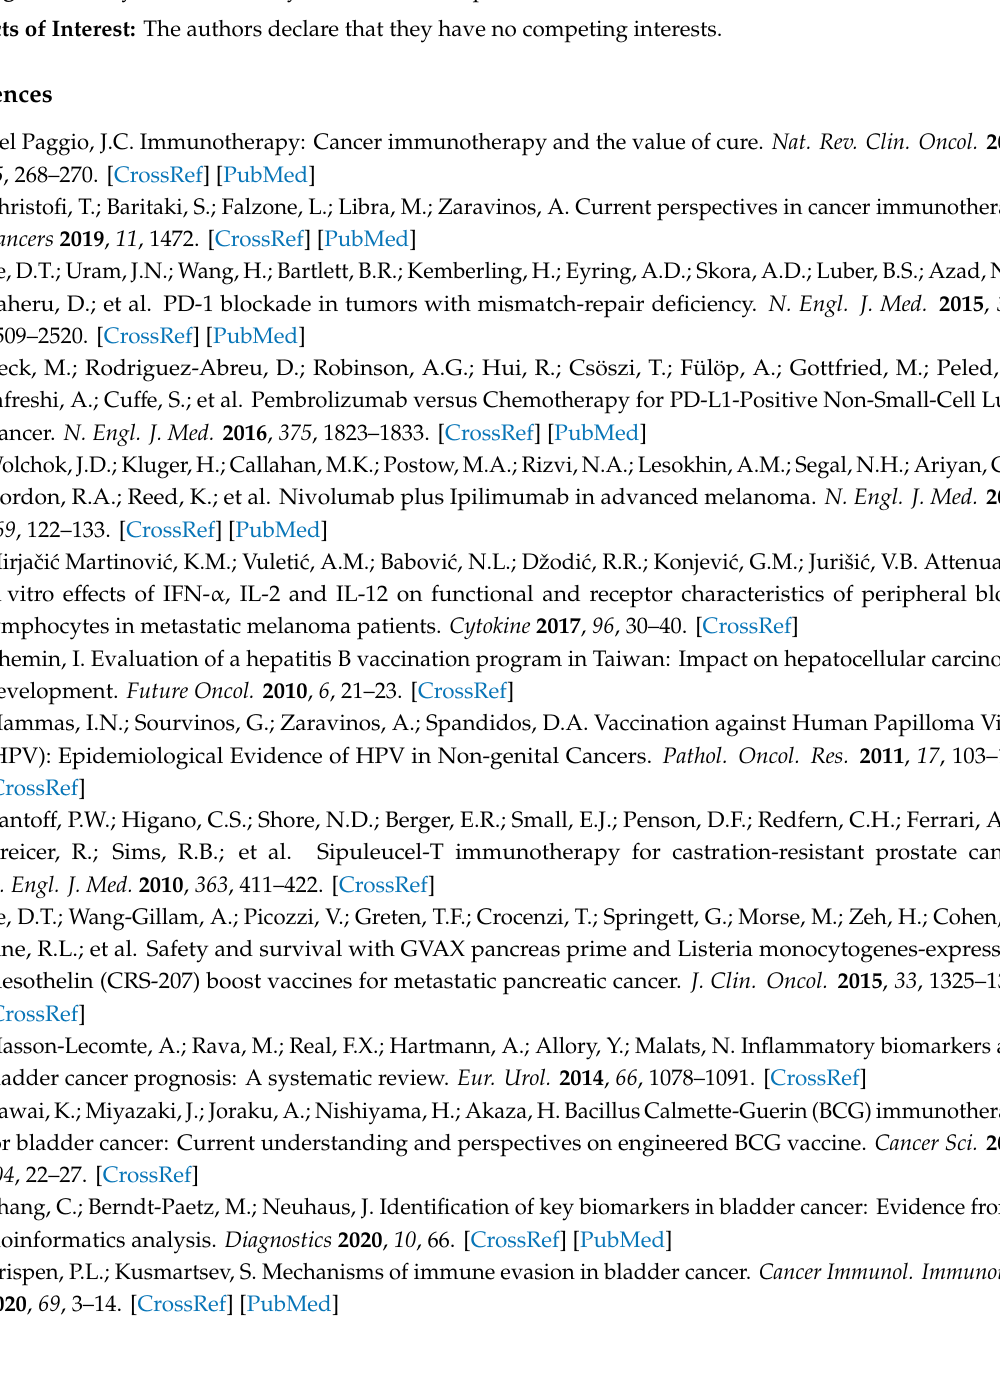
Table S1: Immune cells-associated bio-markers. Table S2: Immune-related bio-markers. Table S3: The bio-markers of other